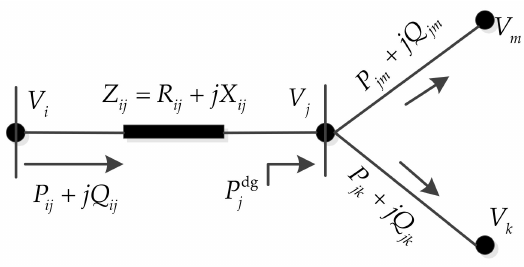
Figure 3. Power flow of the electric